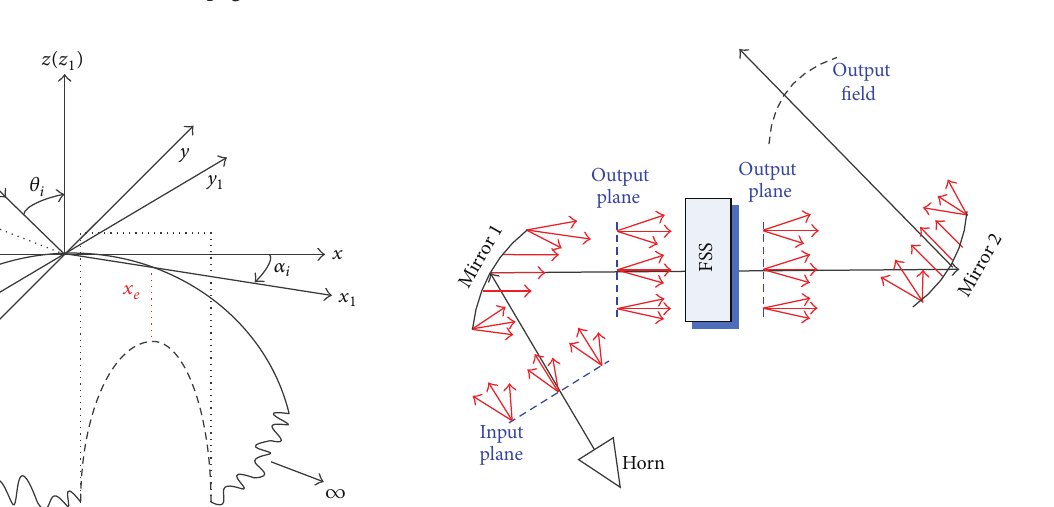
Figure 3: Scheme of Gaussian beam analysis of QON with FSS.